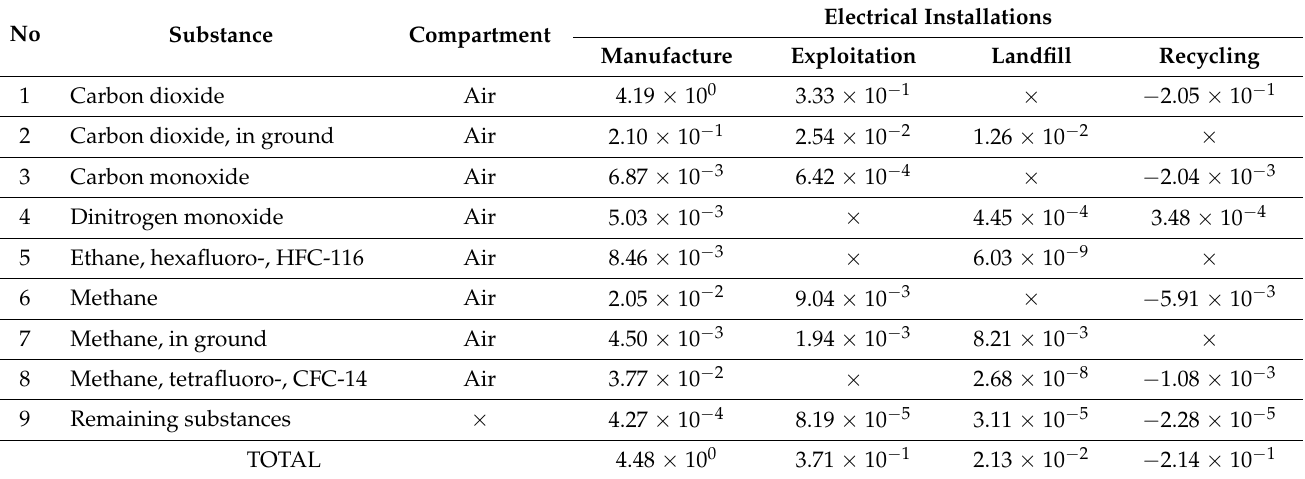
Table 10. The results of grouping and weighing the environmental consequences of emissions of compounds causing global warming due to electrical installations occurring at different stages of the life cycle of the research object.